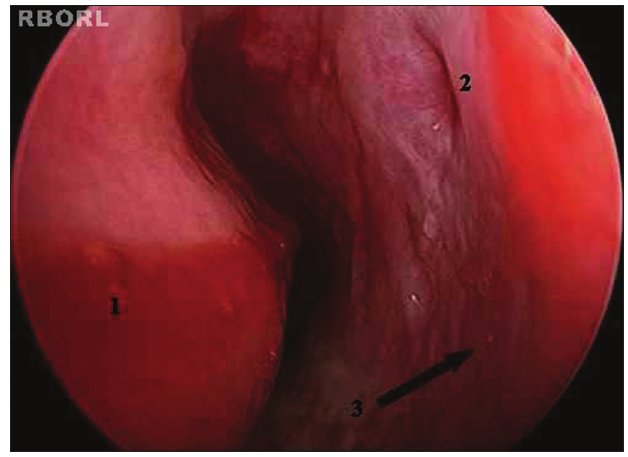
Figura 1. Meato inferior esquerdo. 1: Concha Inferior; 2: Válvula de Hasner; 3: Local da punção na parede lateral no meato inferior